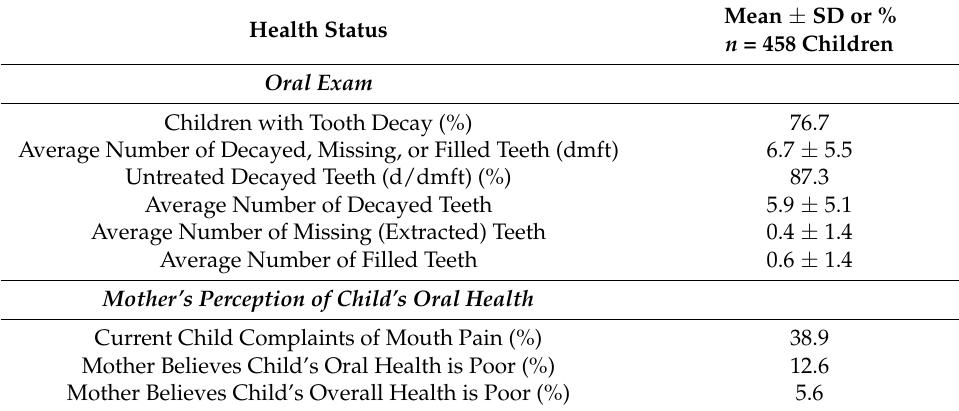
Mean ± SD or % n = 458 Children